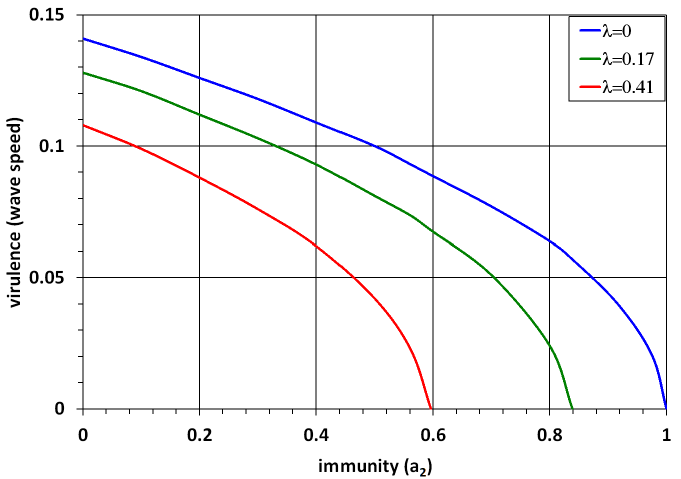
Figure 6. Dependence of virulence (wave speed) on immunity ( a 2 ). The minimal wave speed is found (cid:112) D x k ( 1 a 2 ) for the 1D problem. The upper curve corresponds to λ ( y 0 ) by the formula c 0 = 2 − − λ = 0 (limit of large y 0 ), the middle curve to λ = 0.17 ( y 0 = 0.1), and the lower curve to λ = 0.41 ( y 0 = 0.2). The values of parameters: D x = D y = 0.005, b = 1, k = 1, f ( v ) = ( a 1 v + a 2 ) e − a 3 v , a 1 = 15, and a 3 =